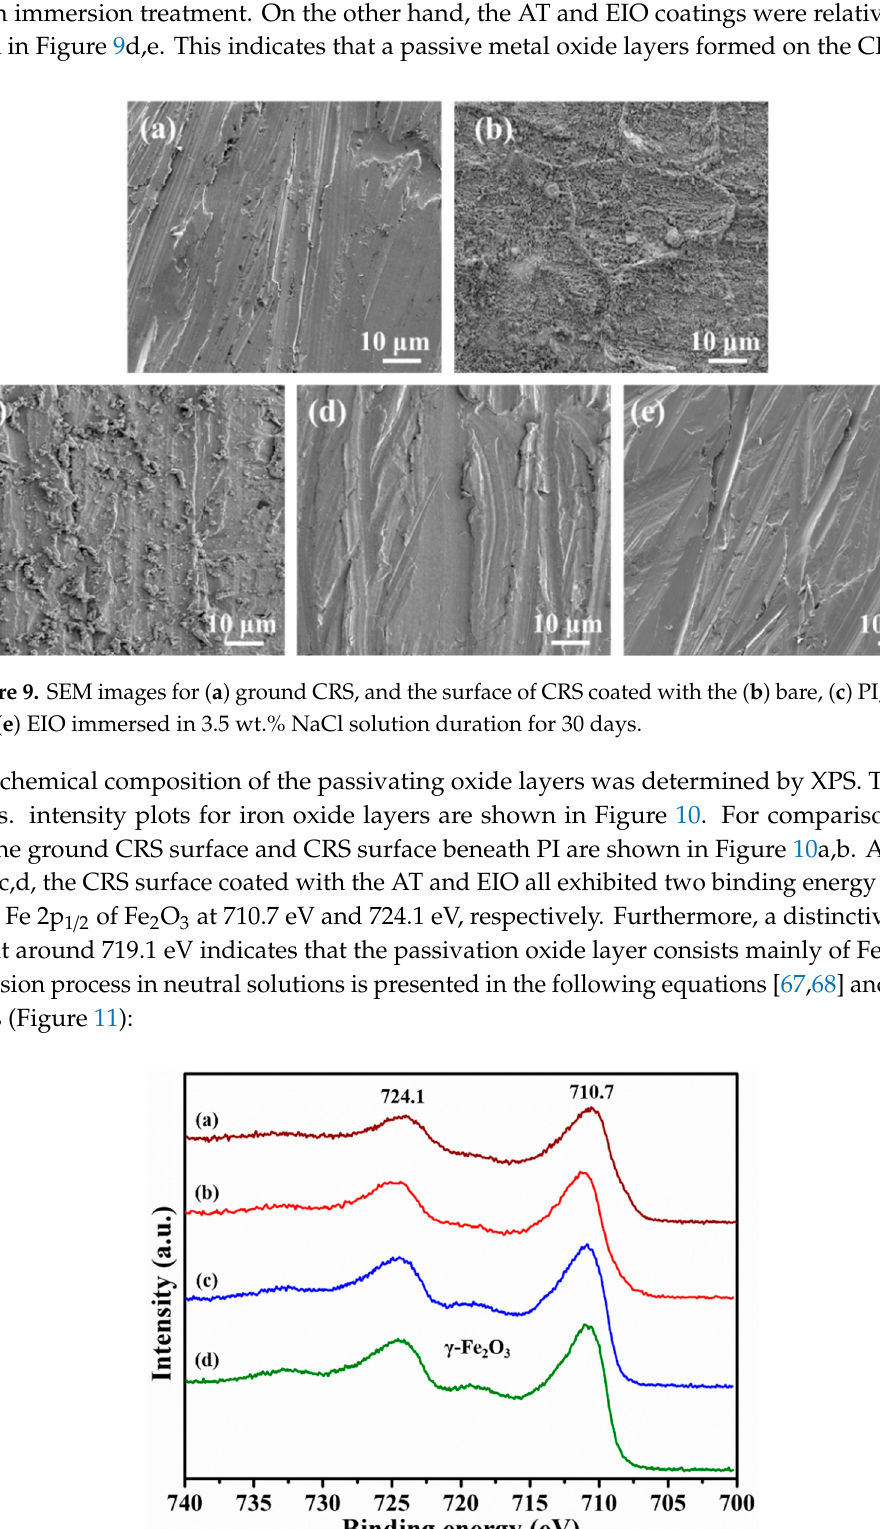
Figure 11. Schematic diagrams of the mechanism of CRS passivation by EIO coatings. 4. Conclusions In this study, the aniline tetramer capped electroactive imide oligomer (EIO) was successfully synthesized and applied as an anti-corrosion coating for a cold-rolled steel electrode. The precursor of the EIO, electroactive amic acid oligomer (EAAO), is limited due to its high solubility in common organic solvents. The anti-corrosive properties of the EIO coating were evaluated by Tafel curves and EIS. Further investigation of the oxidation products underneath the coating using SEM and XPS concluded that the EIO coating facilitated the formation of passive metal oxide layers. This study offers a novel method to prepare the soluble electroactive oligomer, which might be useful when applied to protecting metals from corrosion. Author Contributions: Conceptualization Y.-C.C.; methodology, software, formal analysis, and investigation B.-S.H. and G.-H.L.; experiment, data curation and writing—original draft preparation B.-S.H.; writing—review and editing M.-H.T., T.-I Y., and Y.-C.C.; project administration and funding acquisition M.-H.T. Funding: This material is based on work supported by the Ministry of Science and Technology, Taiwan, ROC (grant No. MOST 108-2221-E-167 -020 -; MOST 108-2917-I-167 -001 -). Conflicts of Interest: The authors declare no conflict of interest.